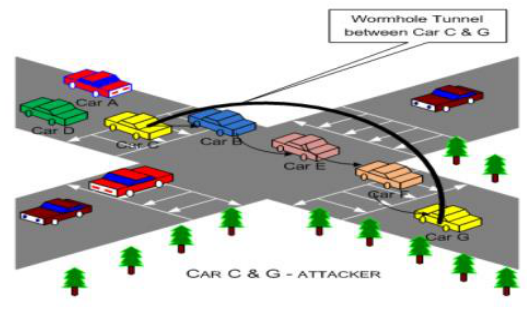
Figure 2. Wormhole Attack(Upadhyaya n.d.)